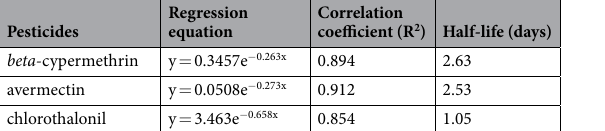
Days after spraying